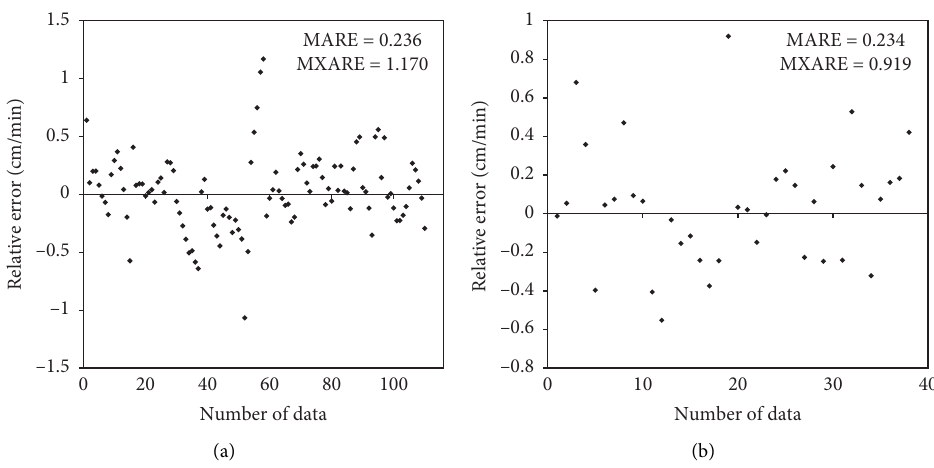
MARE = 0.236 MXARE = 1.170